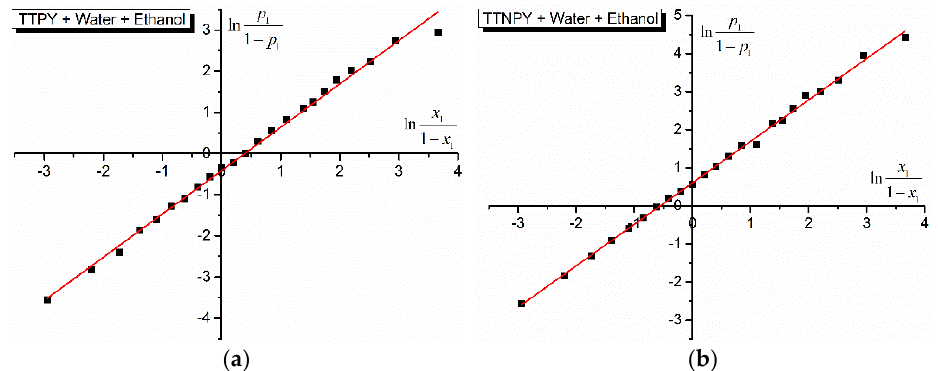
Figure 5. ln p 1 vs. ln x 1 for 4-tolyl-1,2,4-triazol-1-ium phenacylid (TTPY) ( a ) and 4-tolyl-1,2,4- 1 − p 1 1 − x 1 triazol-1-ium-4 (cid:48) -nitro-phenacylid (TTNPY) ( b ) in binary solvent mixture water (1) + ethanol (2).